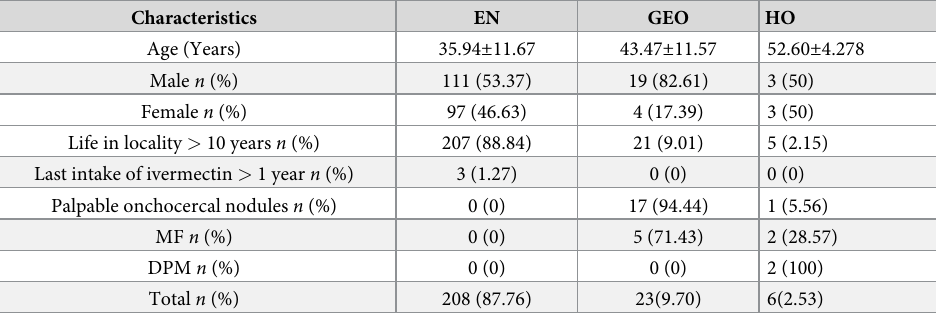
Table 1. Characteristics of the study